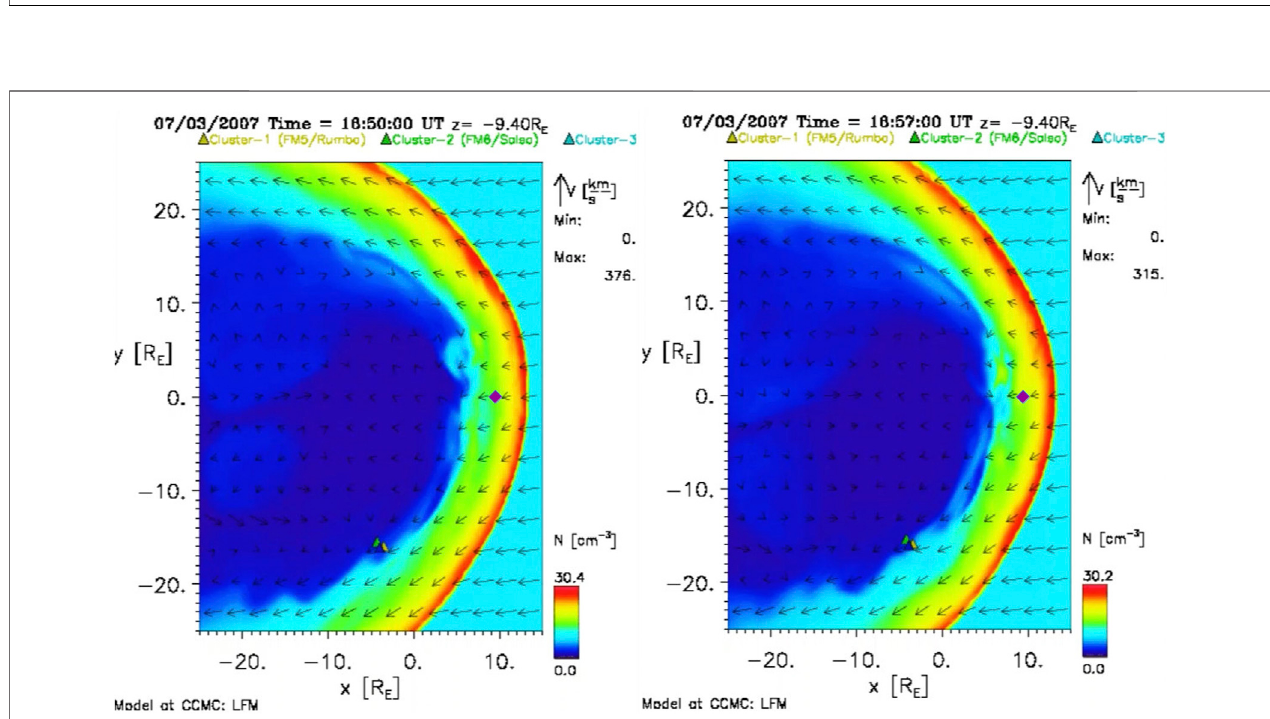
FIGURE 12 | Snapshot of the Global MHD (LFM-model) simulation in Solar Magnetic coordinates, driven with solar wind dynamic pressure variations, in the XY - plane with Z (cid:1) − 9.4 R E (solar magnetic coordinates) for July 3, 2007 at 1650 (on the left) and 1657 UT (on the right). Colors represent plasma density (see color bar), arrows represent plasma velocity, and the triangles show the location of the four Cluster spacecraft. The purple diamond denotes the approximate ( X , Y ) location of the THEMIS-E spacecraft (with Z GSE ≈ − 2.4 R E ).